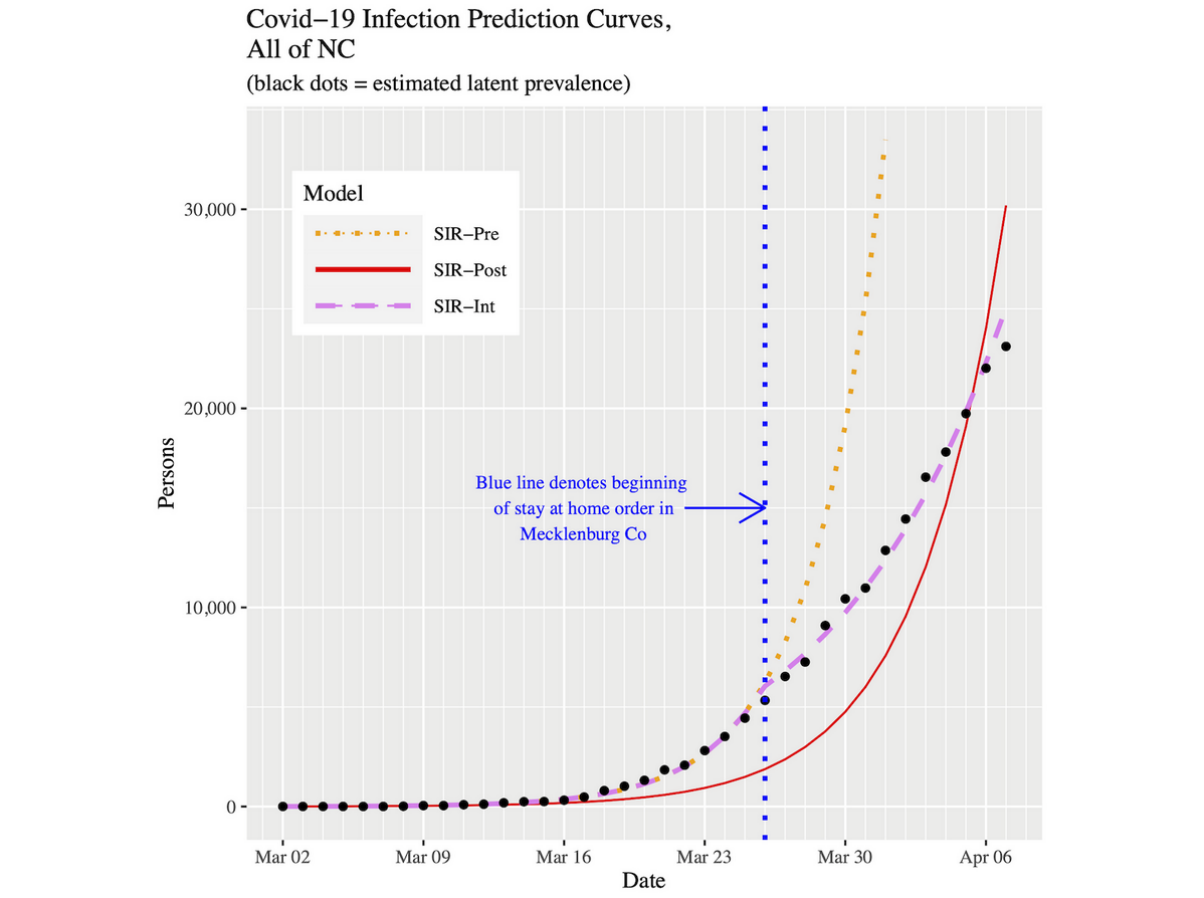
Figure 5. Infection prevalence prediction curves for NC up to April 7, 2020. COVID-19: coronavirus disease; NC: North Carolina; SIR: